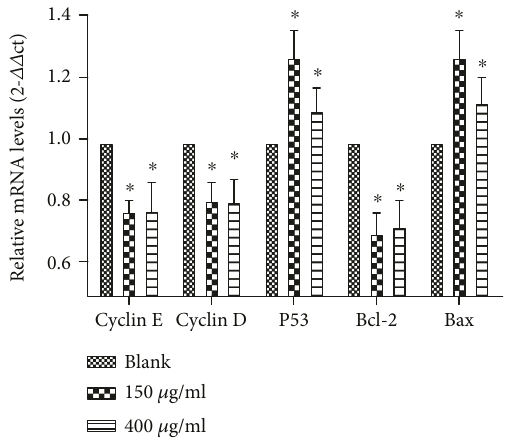
Figure 5: E ff ect of radix hedysari polysaccharide on cytokines in glioma